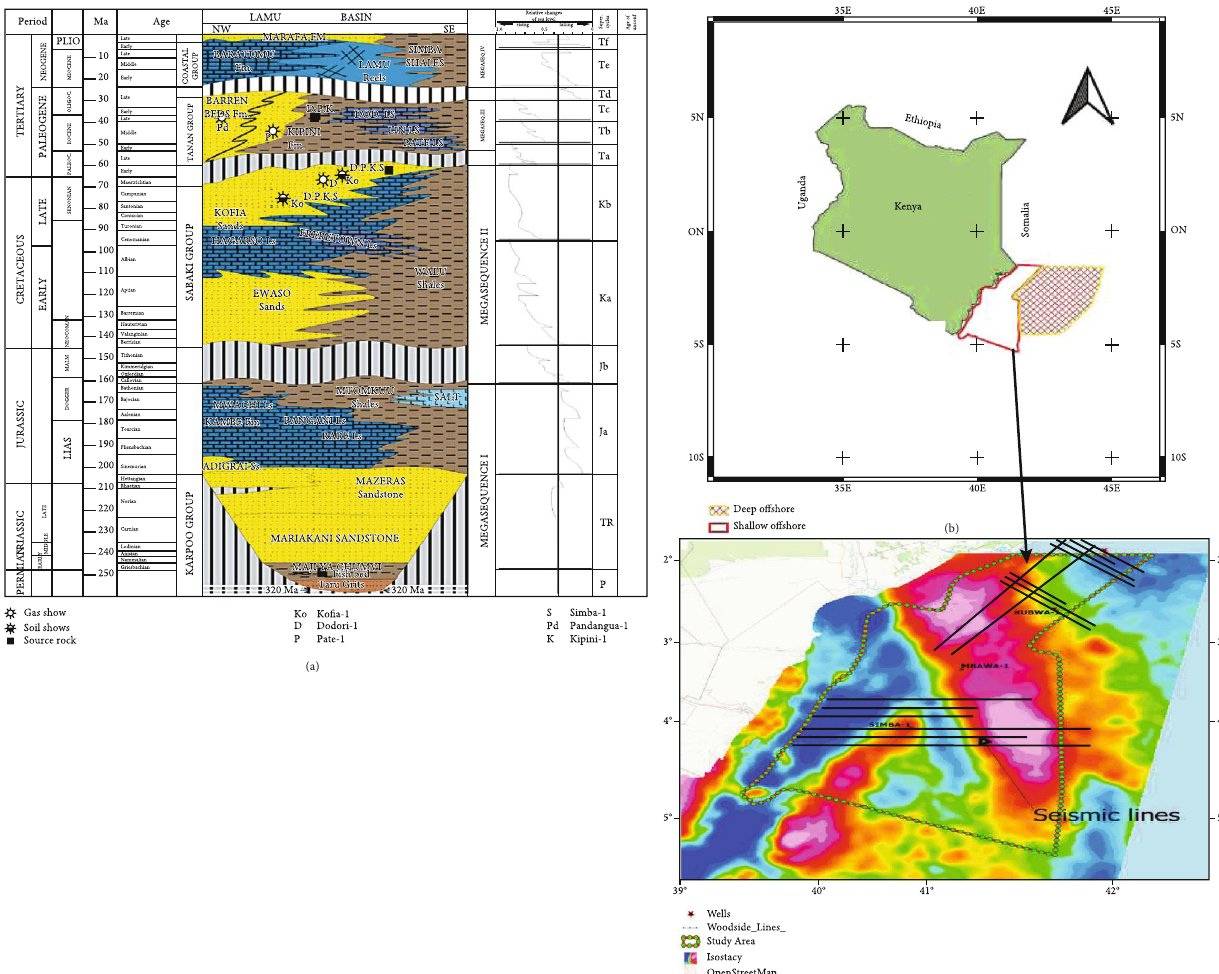
Figure 1: (a) Stratigraphic section divided into four signi fi cant sequences based on the geological and geophysical well data and outcrop studies ranging from Triassic through to Tertiary age [4]. (b, c) Map of Kenya showing the area of study outlined in red (b) and red/ green circles in (c). Source: (b) National Oil Corporation of Kenya (NOCK) Library and (c) an overlay of Isostatic gravity anomaly map, seismic lines, some drilled wells, and area of